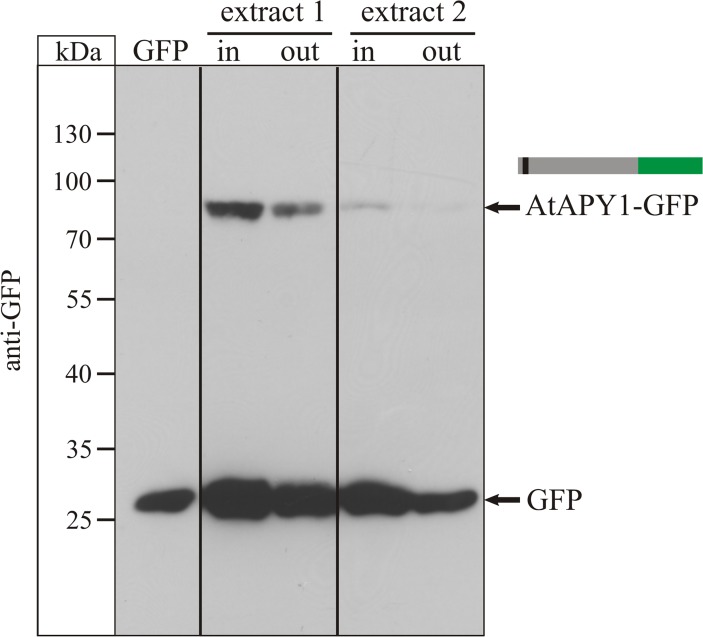
Detection of extracted AtAPY1-GFP.A Western blot analysis of two different crude protein extracts before (= in) and after (= out) the immobilization by GFP-multiTrap is shown. Equal volumes of extract (15 μL each) were loaded per lane, its proteins subjected to 10% SDS-PAGE, transferred to a nitrocellulose membrane and incubated with antibodies to GFP. The arrows mark the signals of the AtAPY1-GFP fusion protein and free GFP, respectively. The explanation of the colors in the schematic representation of AtAPY1-GFP can be found in Fig. 2. Recombinant GFP (19 ng) served as a positive control and quantitative reference for densitometric evaluation of signal intensities. With this, the total amounts of bound AtAPY1-GFP from 100 μL extract 1 and 2 were calculated as 130 ng and 22 ng, respectively. The image shows bands from the same exposure of the same membrane, but non-pertinent lanes were cropped as indicated by vertical lines. The shown signals are representative of at least five separate Western blot analyses of different GFP-multiTrap immobilization experiments.